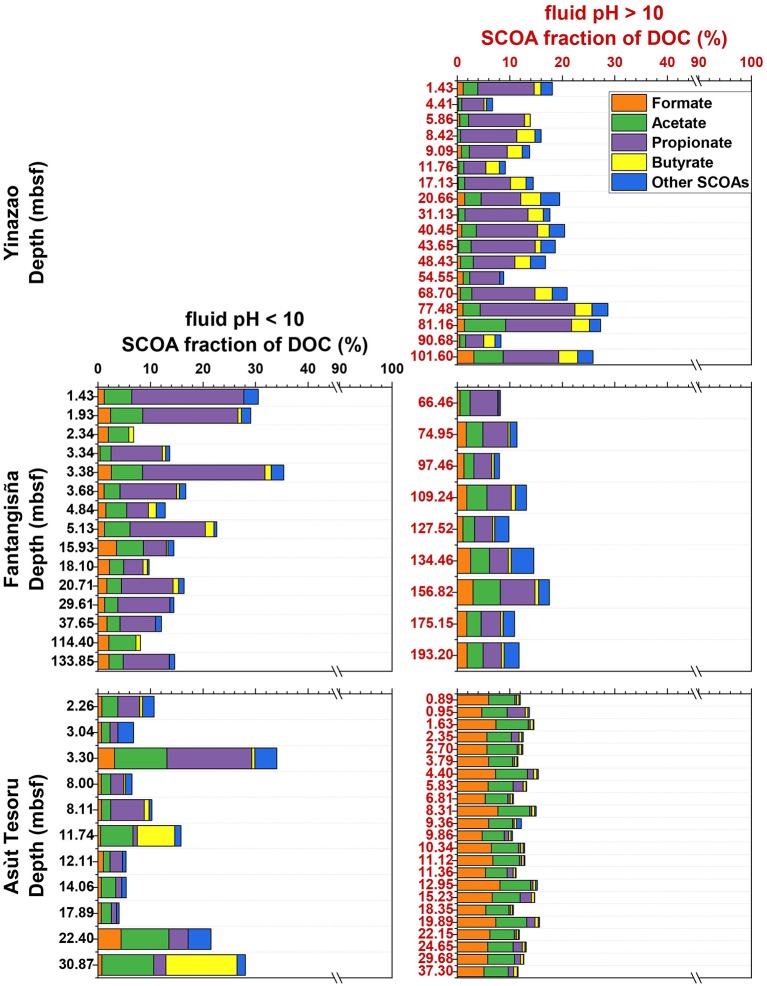
SCOA percent fractions of DOC vs. depth at the Yinazao, Fantangisña, and Asùt Tesoru mud volcanoes. Black labeling indicates moderate pH fluids with an average pH < 10 (Left), red labeling indicates high pH fluids with an average pH > 10 (Right).